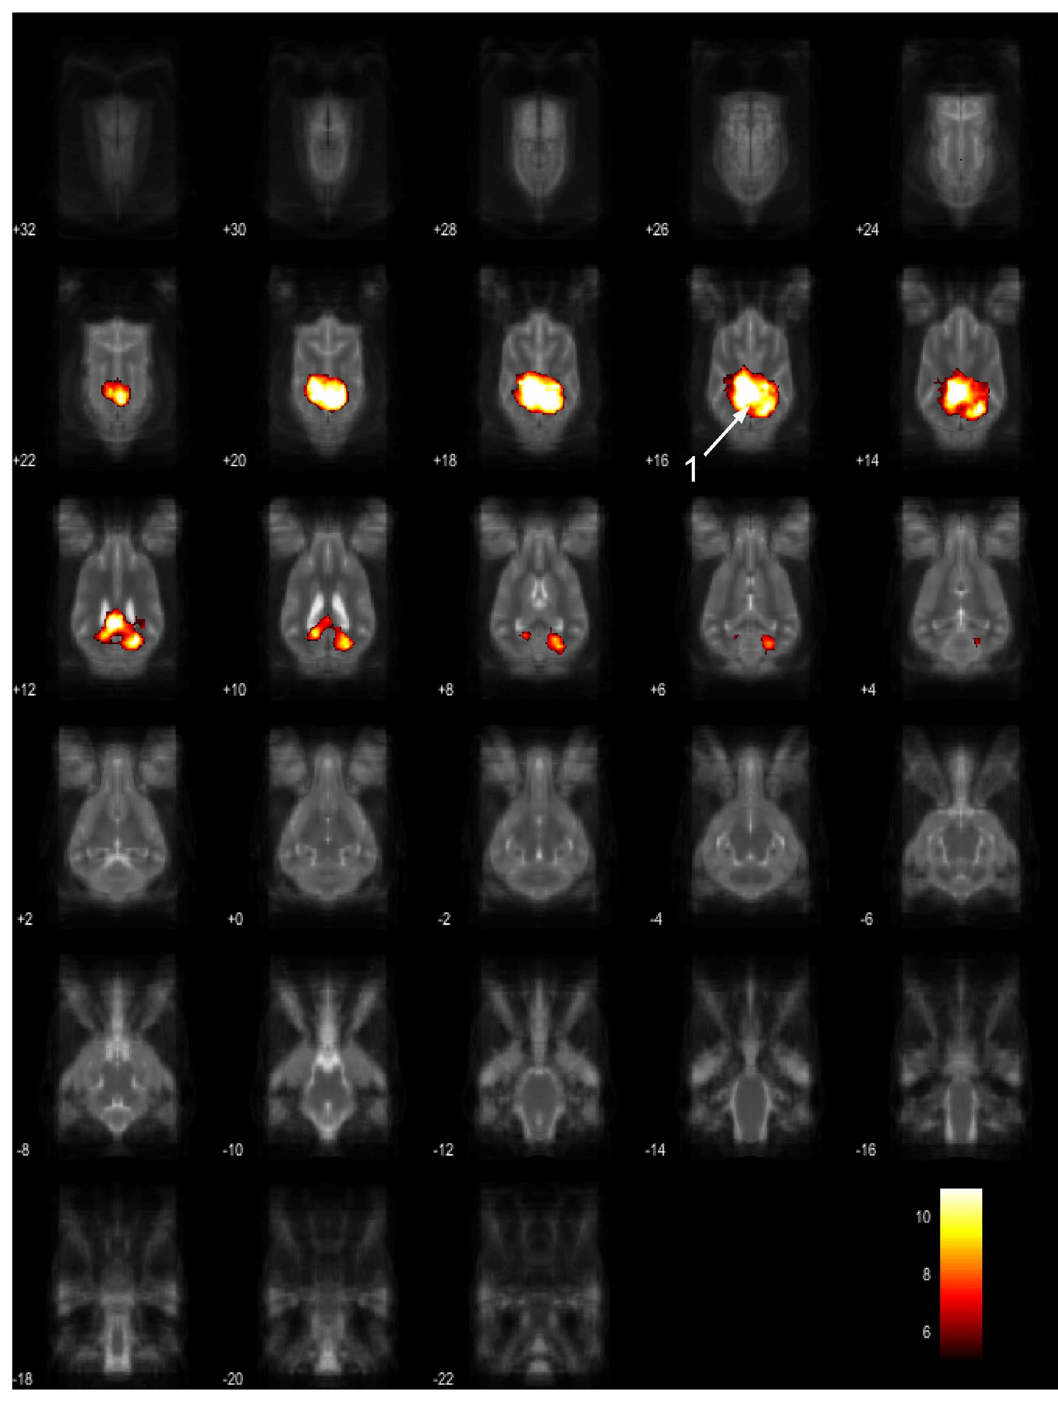
Figure 11. Resting-state network component H from the 15 component gICA. We report the results with a voxel-wise FDR corrected p < 0.001 and cluster treshold of FDR corrected p < 0.005. gICA components are presented as thresholded T-maps, corrected for multiple comparisons, overlaid on the Nitzsche atlas 15 . 1. mid- cingulate